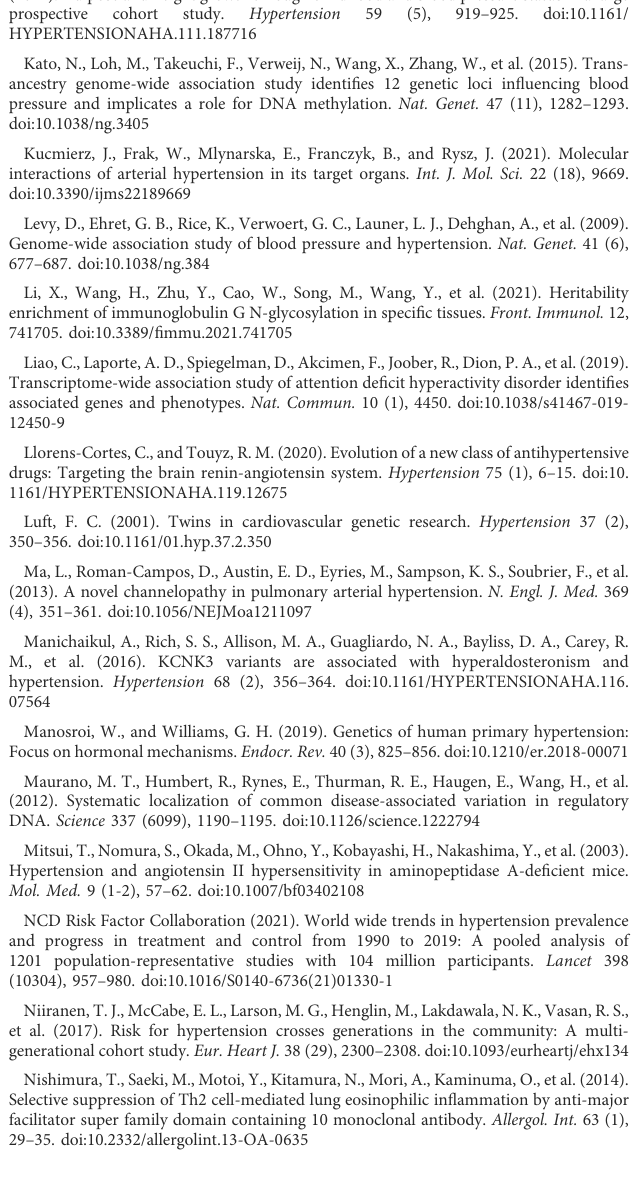
SUPPLEMENTARY TABLE S6 The top 10 gene-set of MAGMA gene-set analysis. SUPPLEMENTARY TABLE S7 UTMOST single-tissue